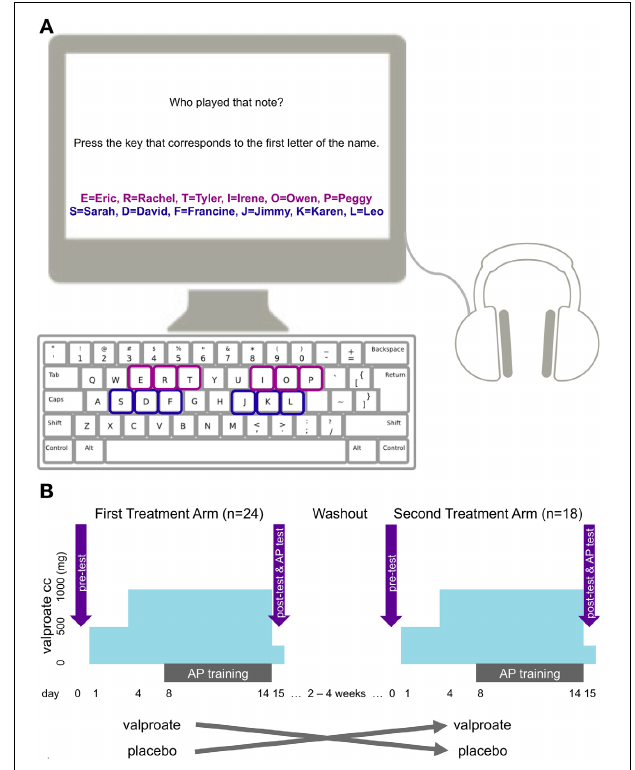
FIGURE 1 | (A) The setup of the AP task. The purple characters and squares indicate names and corresponding keys used in one treatment arm, the blue ones indicate those used in the other treatment arm. Colors appear here for illustration purposes only. Only black characters were used in the actual experiment and response keys were not highlighted. (B) The cross-over design of the study with the two treatment arms, VPA regimen, training and test